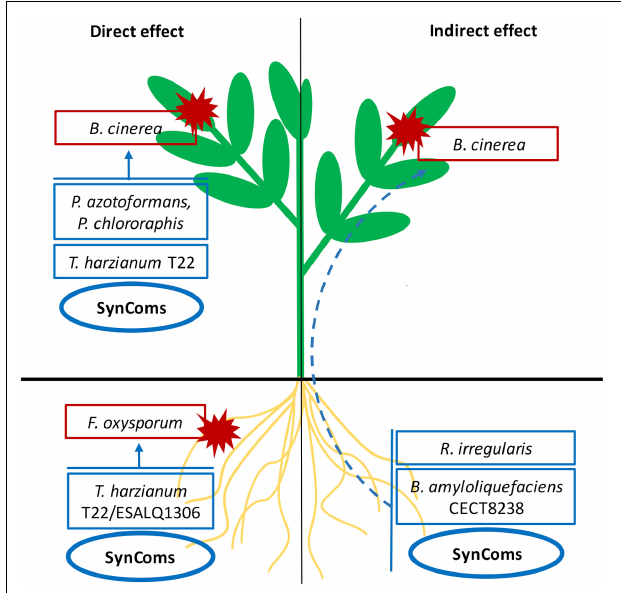
FIGURE 4 | Summary of the microbial treatments showing suppressive effects on Botrytis cinerea and Fusarium oxysporum through direct antagonism (arrows) or the induction of plant of systemic resistance (dashed arrow) after foliar spray and seed